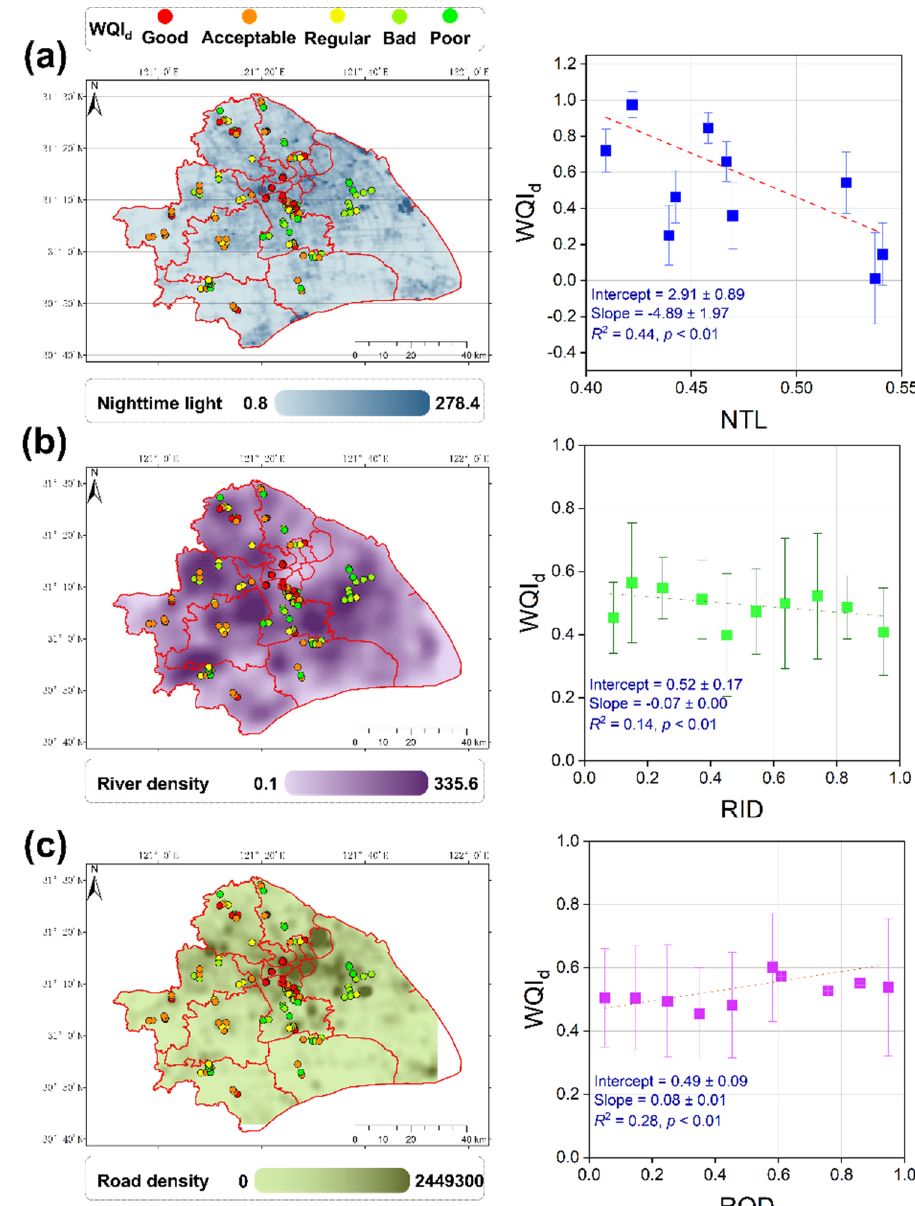
Figure 3. ( a – c ): Grid maps of nighttime light (NTL), river density, and road density of Shanghai in 2019, and their linear regressions with summertime data driven water quality index (WQI d ). The plotted points are median values taken from each (normalized) cluster binned at every increment of 0.1 (all the same as NTL, RID, and ROD). Land use can be clustered into four types: industrial, commercial, residential, and green spaces.